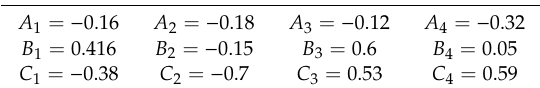
Table 2. System parameters.